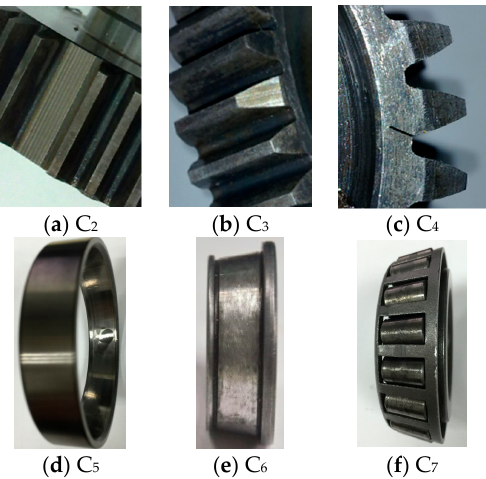
Figure 5. ( a ) Broken tooth; ( b ) Chipped tooth; ( c ) Gear crack; ( d ) Wear of outer race; ( e ) Wear of inner race; and, ( f ) Wear of the rolling elements.